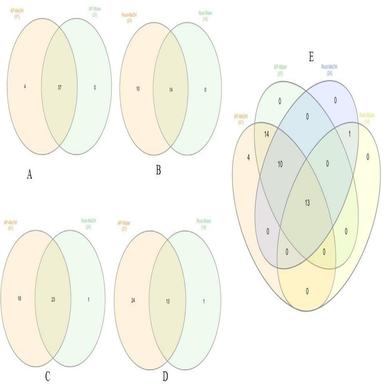
Venn diagrams of identified compound numbers in the tested extracts. A: Compounds numbers in aerial parts (AP) extracts. B: Compounds numbers in root extracts. C: Compounds numbers in methanol extracts. D. Compounds numbers in water extracts. E: Compounds numbers in all extracts.